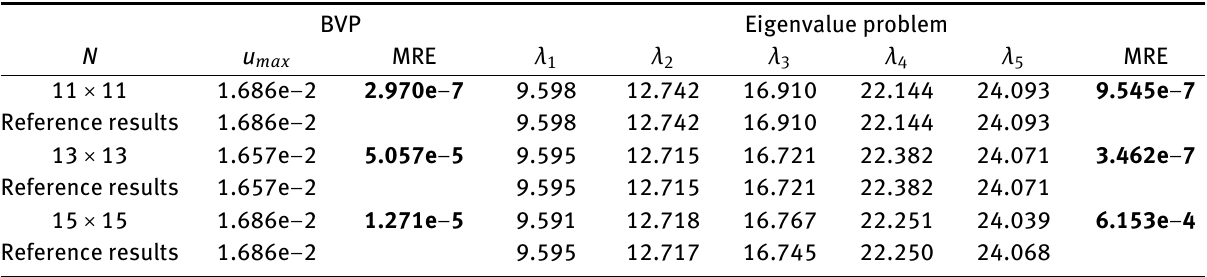
Figure 6: Influence of the shape parameter on the accuracy – left, and condition number – right. Stable basis – solid line, Gaussian kernel – dash line. Results for the BVP on the quarter section of the elliptical domain with boundary conditions given by Eq. (28) implemented by strategy 1. Table 1: The results from solving the biharmonic problems on the quarter section of the elliptical domain. The boundary conditions given by Eq. (28) implemented using strategy 1.